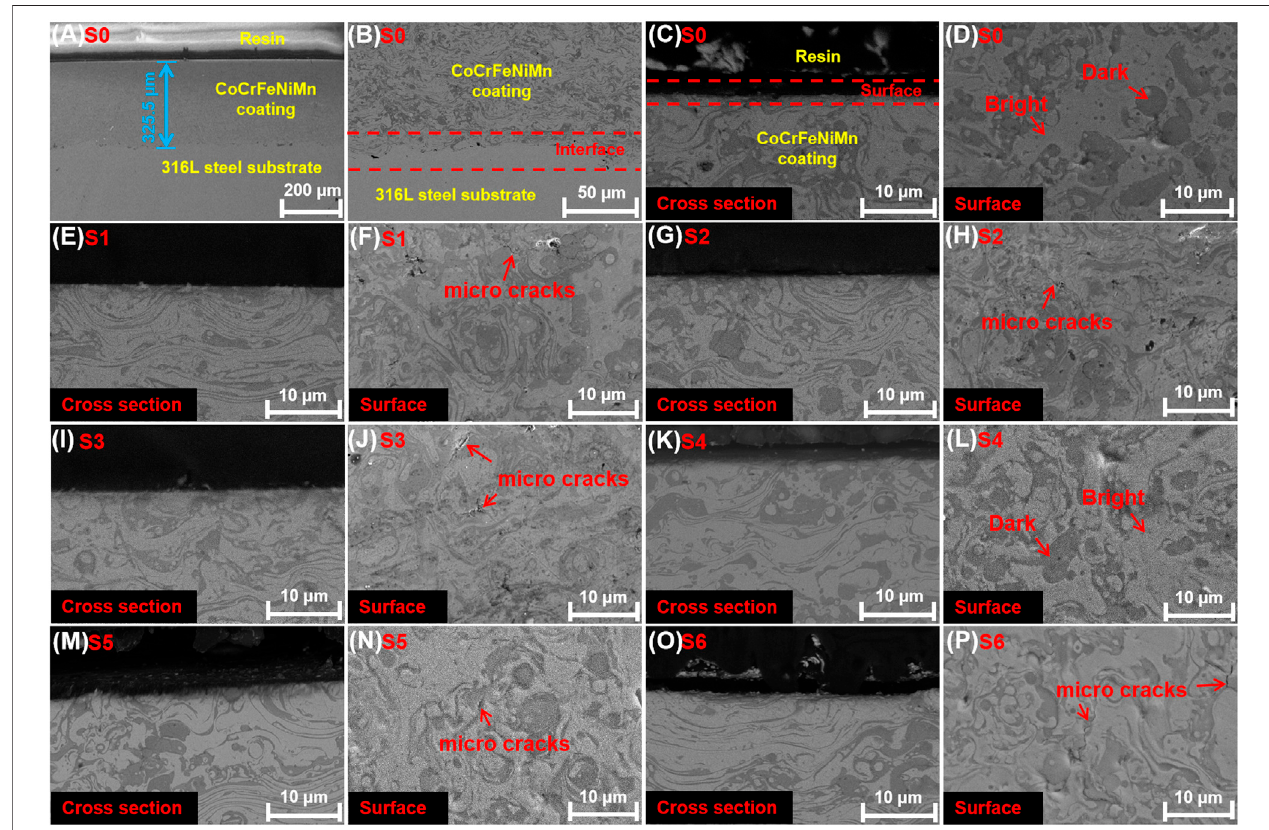
FIGURE 3 | SEM morphologies of the CoCrFeNiMn HEA coatings (A – D) the as-sprayed coatings S0; (E, F) S1; (G, H) S2; (I, J) S3; (K, L) S4; (M, N) S5; and (O, P) S5.